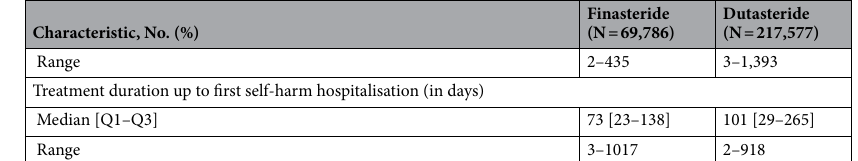
Characteristic, No. (%)